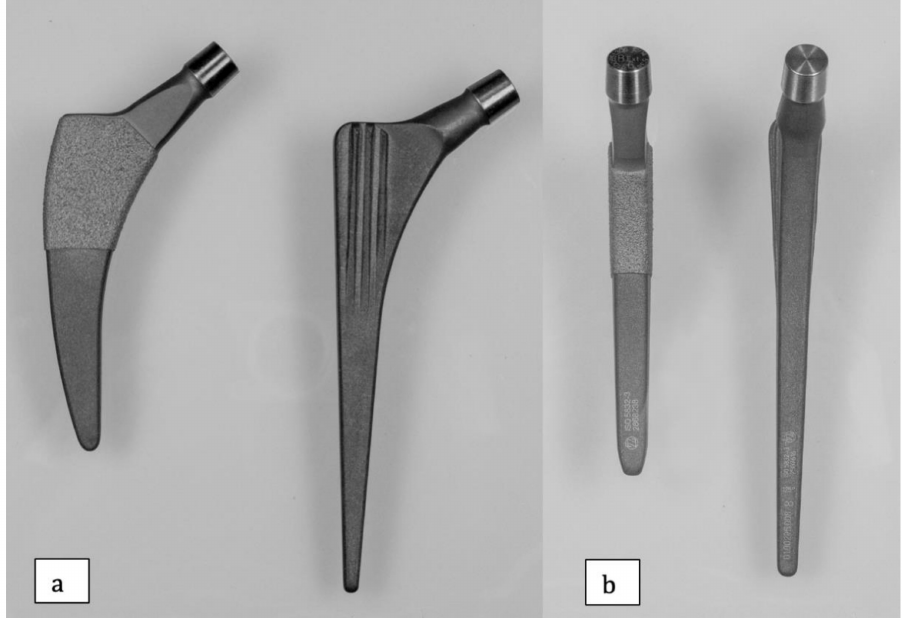
Figure 1. ( a , b ) Femoral component designs. Anteroposterior ( a ) and sagittal profiles ( b ) of the analyzed stems. In both figures, the Fitmore stem is shown left and the CLS stem is shown right.